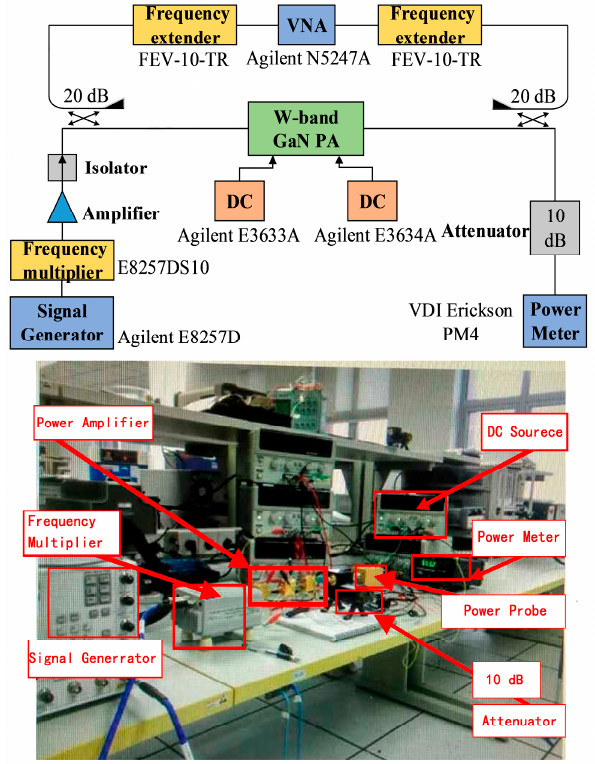
Figure 15. Photograph of the measurement setup for the W band MMIC power amplifier.